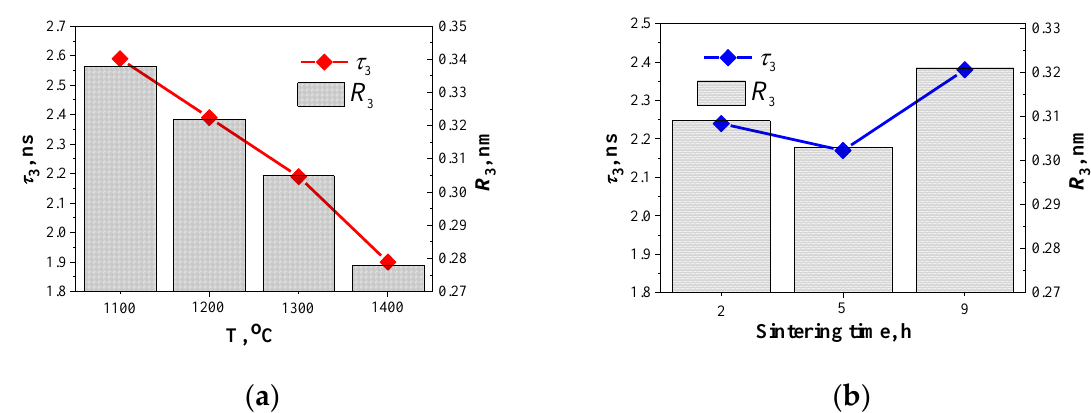
Figure 6. Dependencies of lifetime τ 3 and nanopores radius R 3 calculated according to Tao-Eldrup model for MgAl 2 O 4 ceramics obtained at 1100 – 1400 °C and sintering duration of 2 h ( а ) and at 1300 °C and sintering duration 2, 5, and 9 h ( b ).